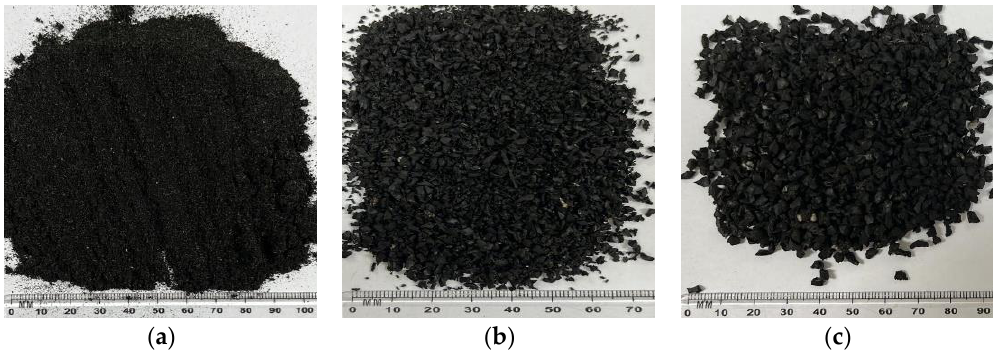
Figure 1. Granules of sizes ( a ) 0.0 – 0.5 mm, ( b ) 0.5 – 2.0 mm, and ( c ) 2.0 – 3.5 mm.